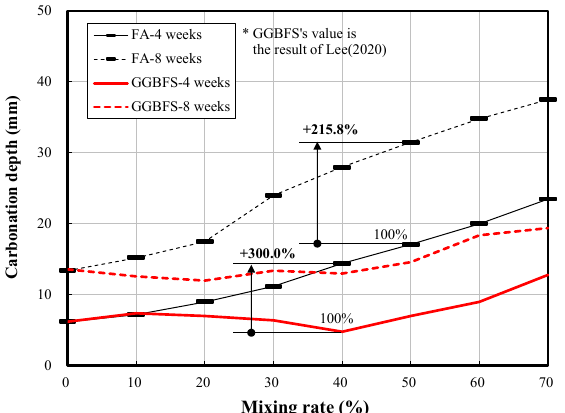
Figure 11. Results of the carbonation depth of OPC and FA compared with GGBFS as measured by Lee (adapted from [26]) in terms of the mixing rate.